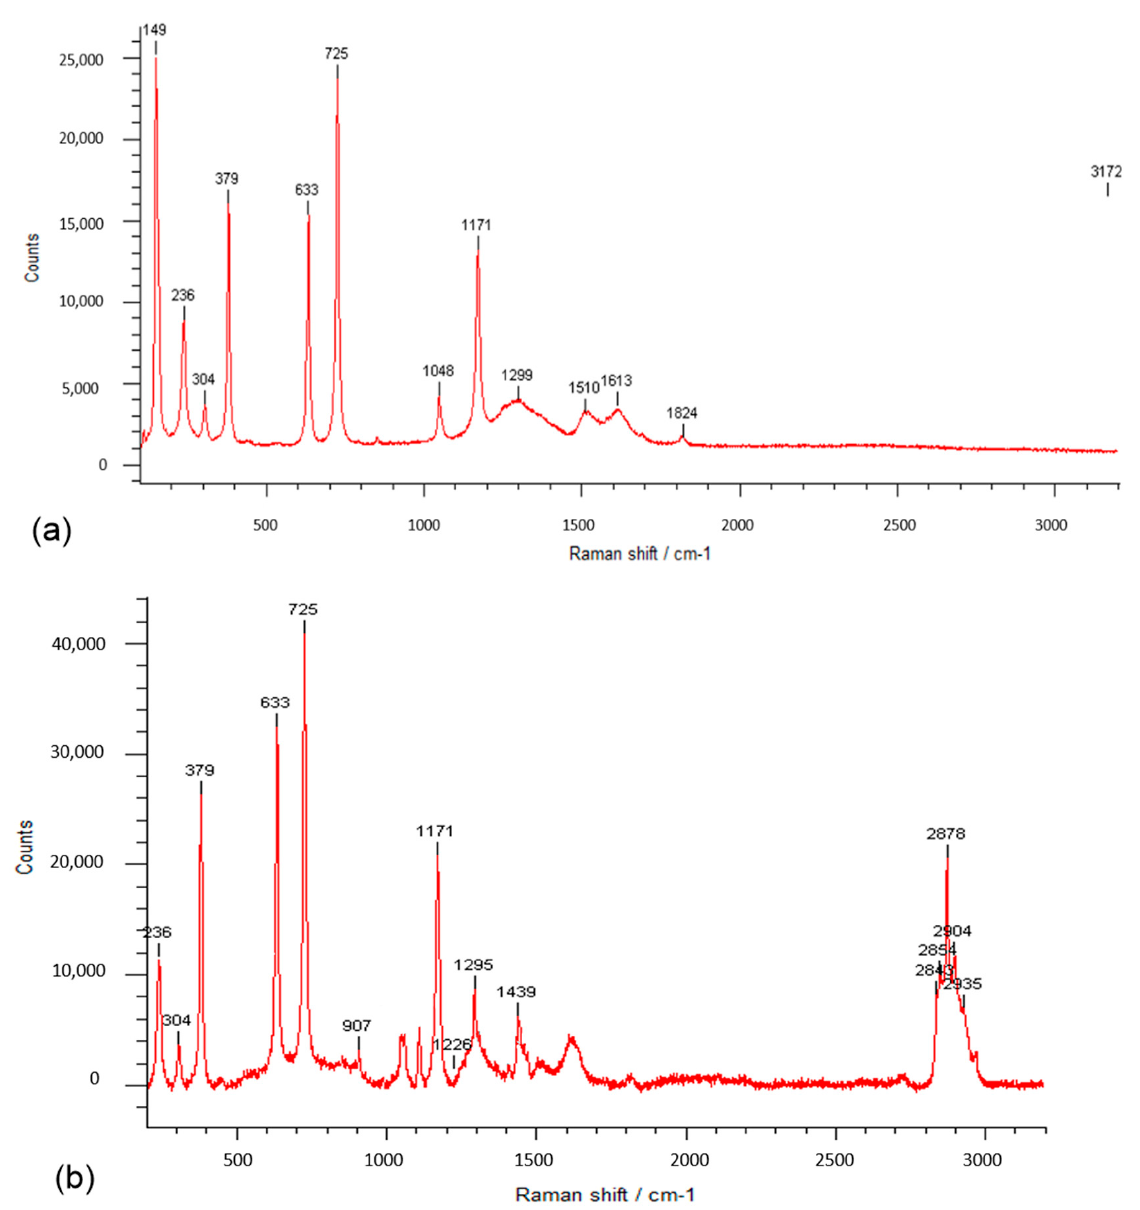
Figure 5. Raman spectra of squaric acid ( a ) and PEBSA copolymer ( b